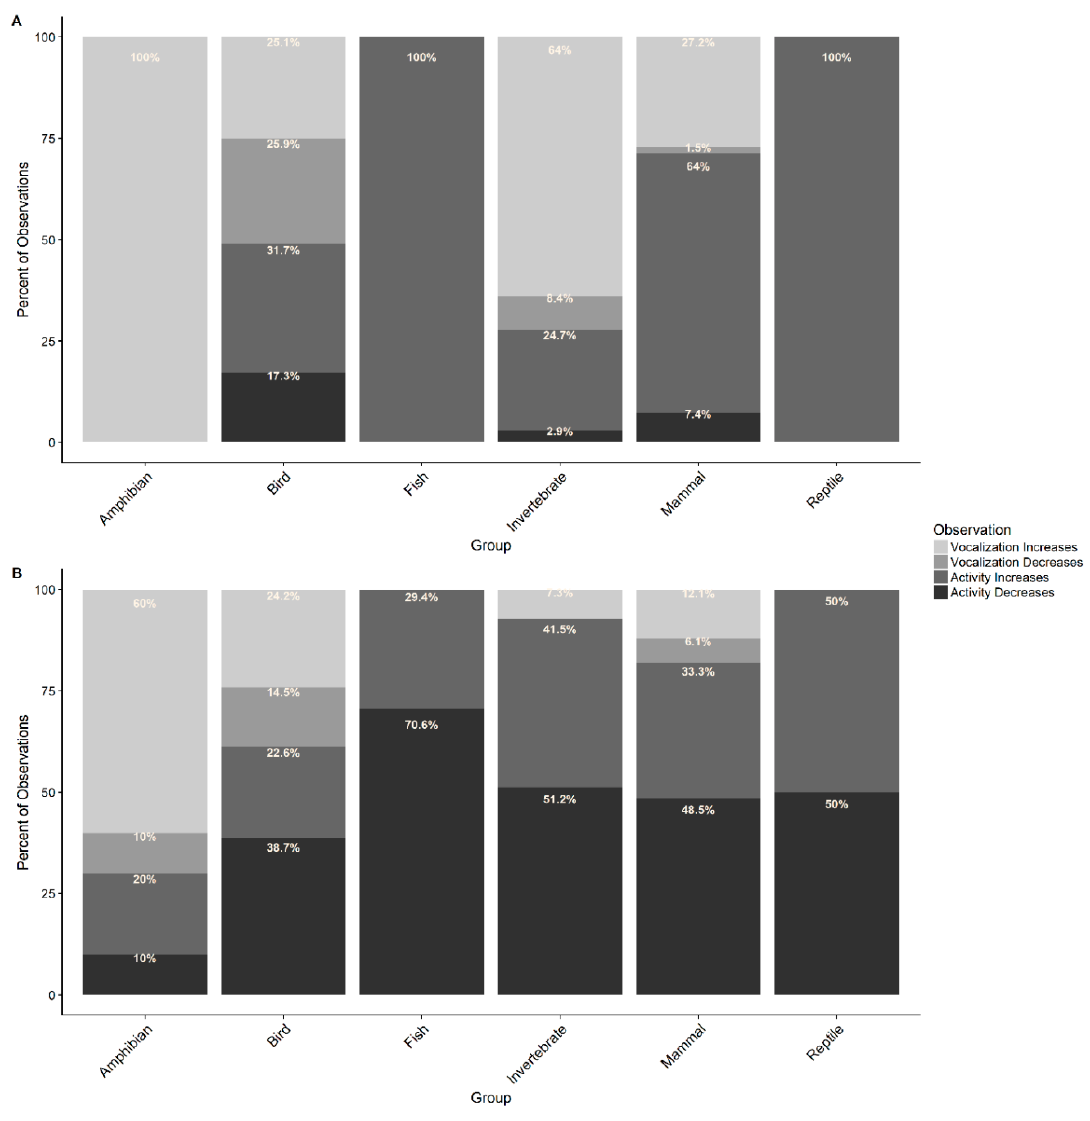
Figure 2. The proportion of behaviors observed for each group of animals recorded by social media ( A ) and scientific literature ( B ) is reported as a percent of the total number of observations made for each group of animals by the source (each animal grouping totals 100% in each source type).